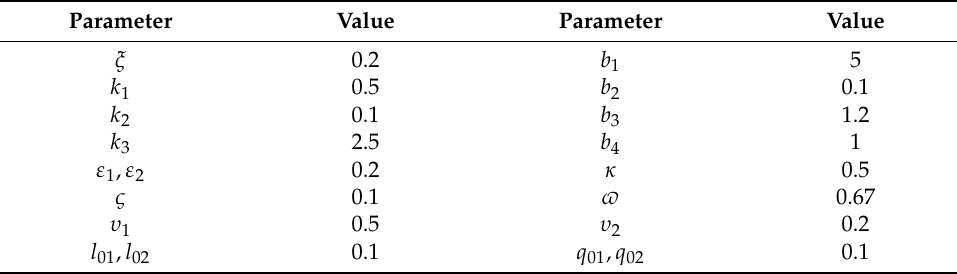
Table 2. The parameters of sliding mode manifold and adaptive